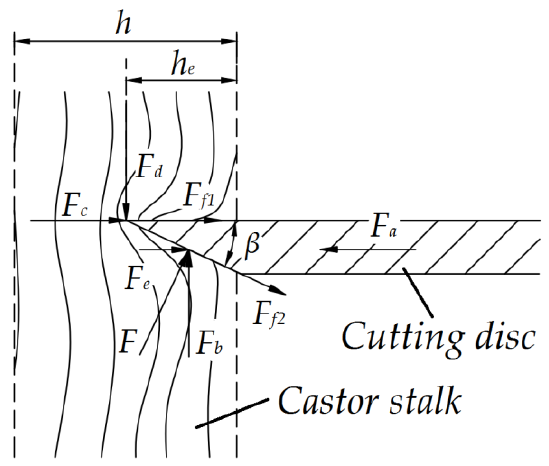
Figure 1. Schematic of Collision force and velocity of stalk.